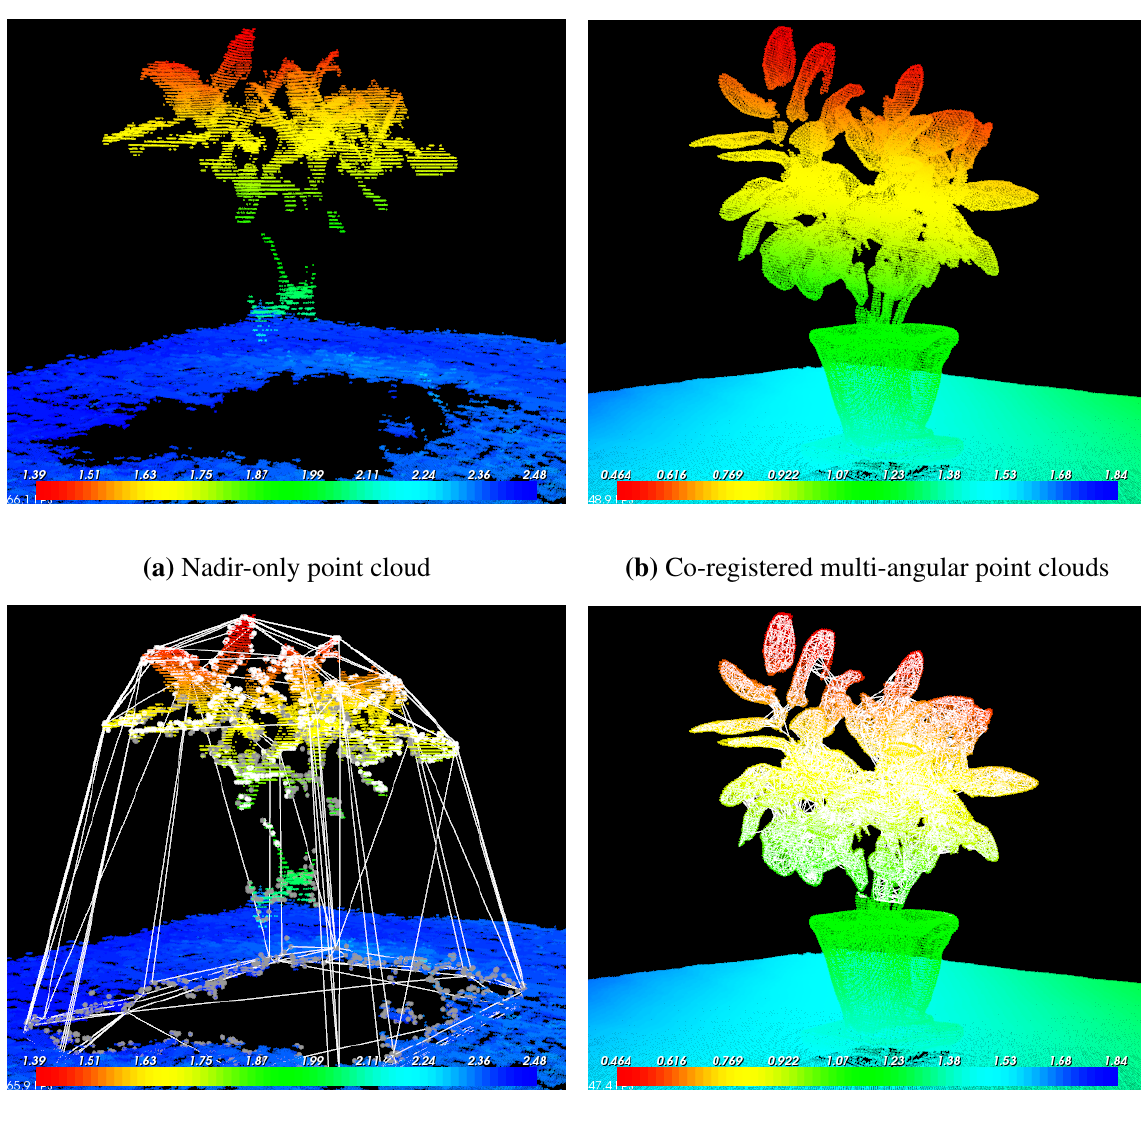
Figure 2. Comparison between nadir-only (a and c; collected using the “Tower Mode”) and co-registered multi-angular (b and d; collected using the “Multi-angular Mode”) point clouds. The upper panels show the point clouds viewed from an arbitrary horizontal perspective. The lower panels show convex ( c ) and concave ( d ) hulls superimposed as white lines. Panel ( c ) shows the shade (grey) and border (white) points used to define the convex hulls. Point cloud color scale is distance (meters) from the sensor at